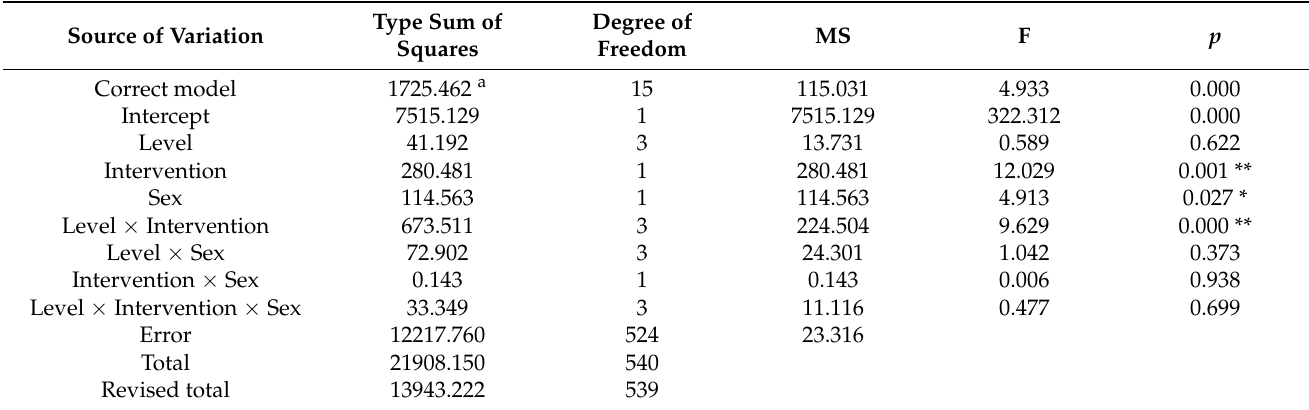
Table 6. The intersubjective effect test of the progress of children and adolescents’ physical fitness scores after the experiment.